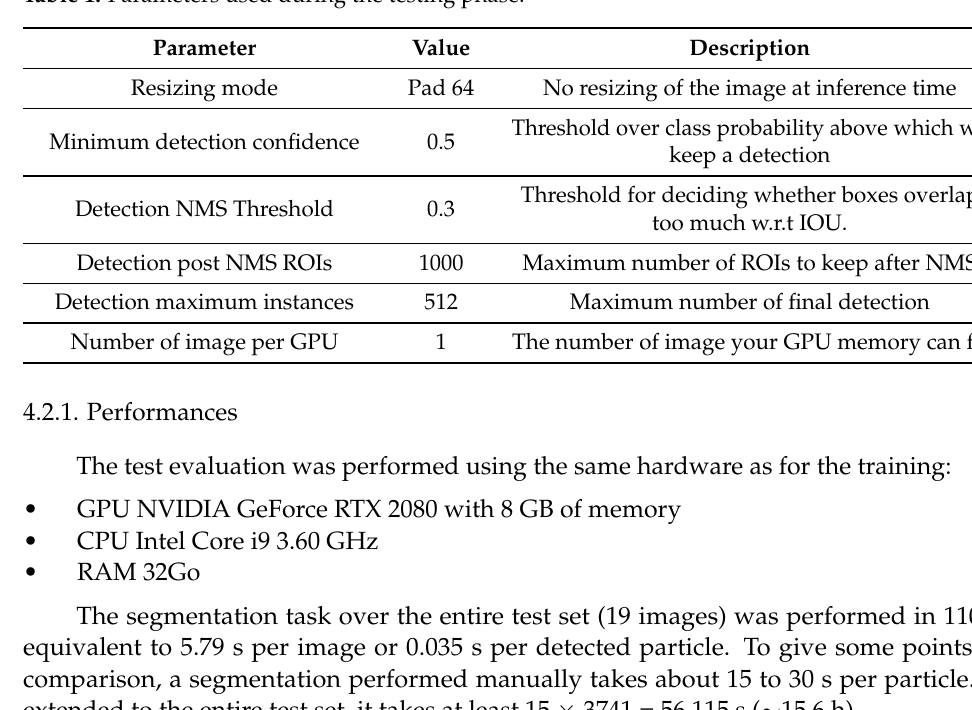
Table 1 explicits the different parameters used during the test phase. Table 1. Parameters used during the testing phase.